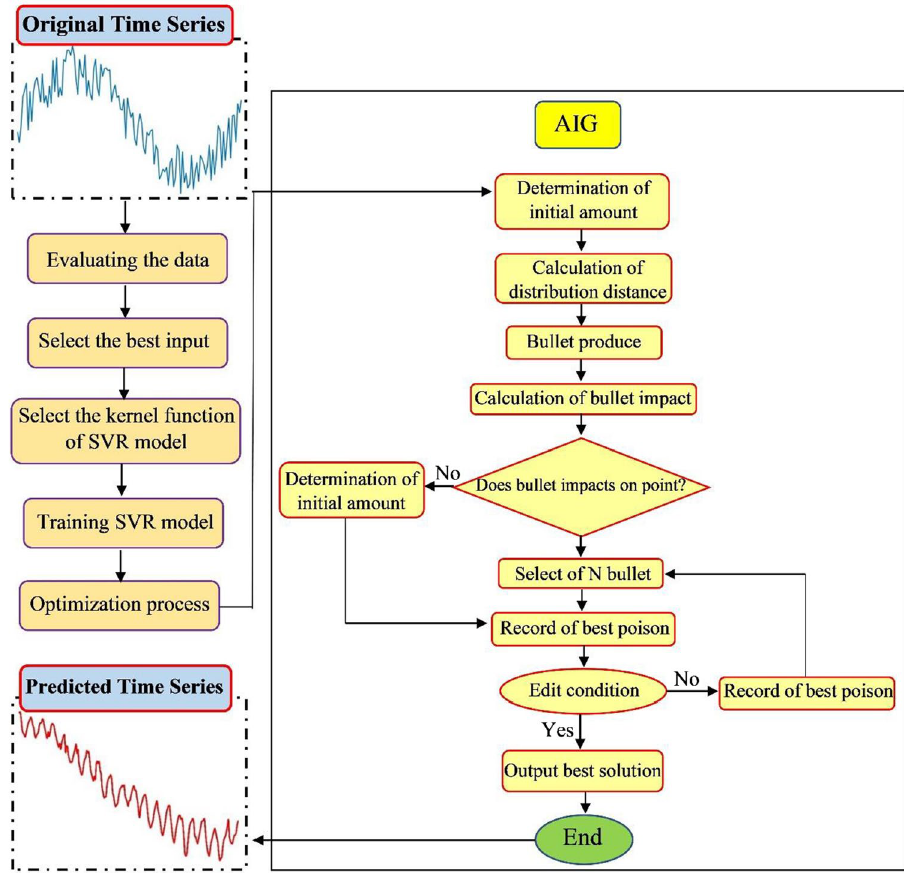
Fig. 2 Flowchart of SVR-AIG